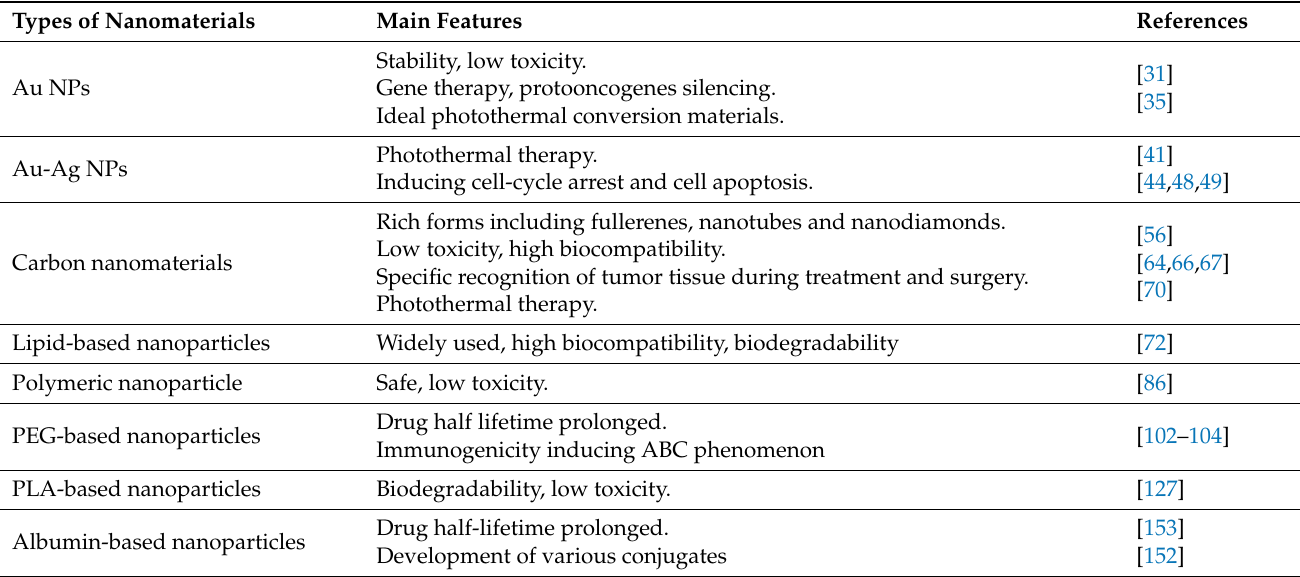
Table 3. Major nanoparticles involved in this review and their